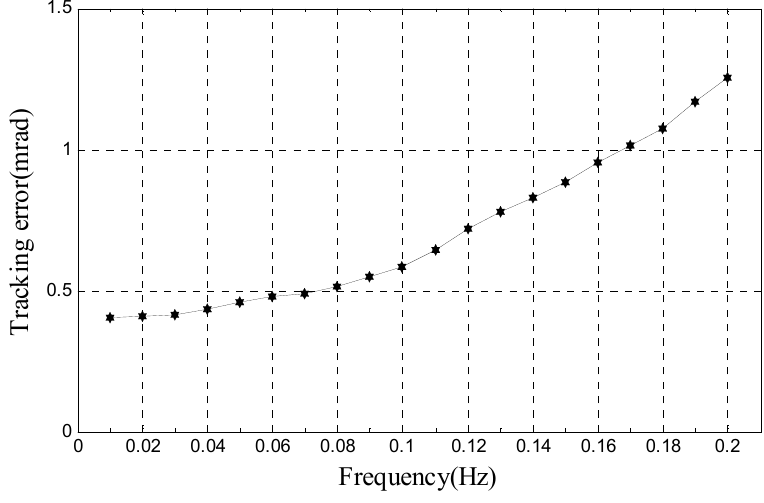
Figure 13. Proposed method’s relationship of tracking error and frequency.